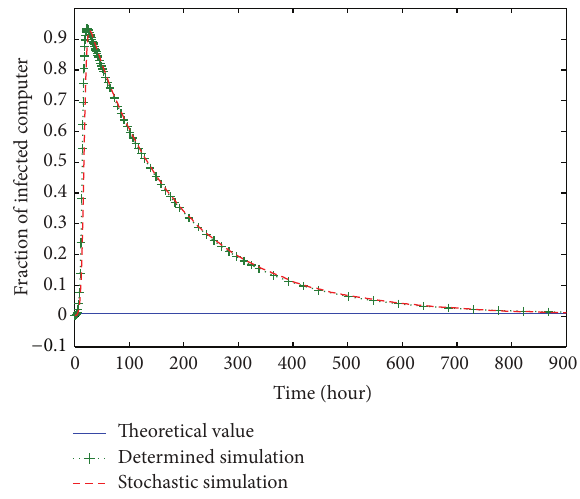
Figure 2: The change figure of proportion of infected computers 𝐼 𝑐 𝑖 with time 𝑡 in the 𝑖 th subnet.